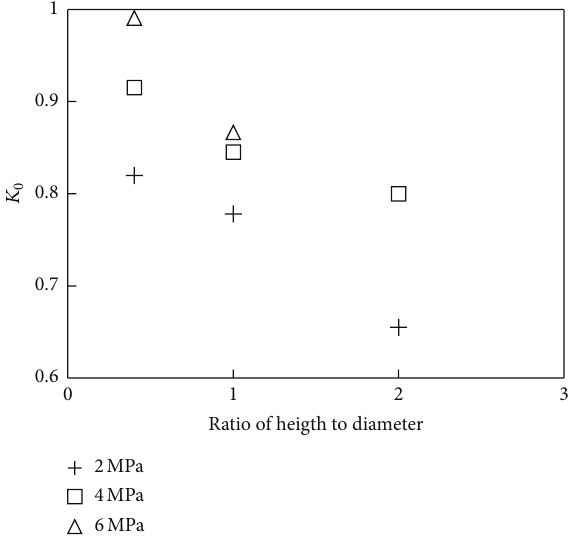
Figure 5: 𝐾 0 at various pressures versus ℎ/𝑑 (min, 2010).